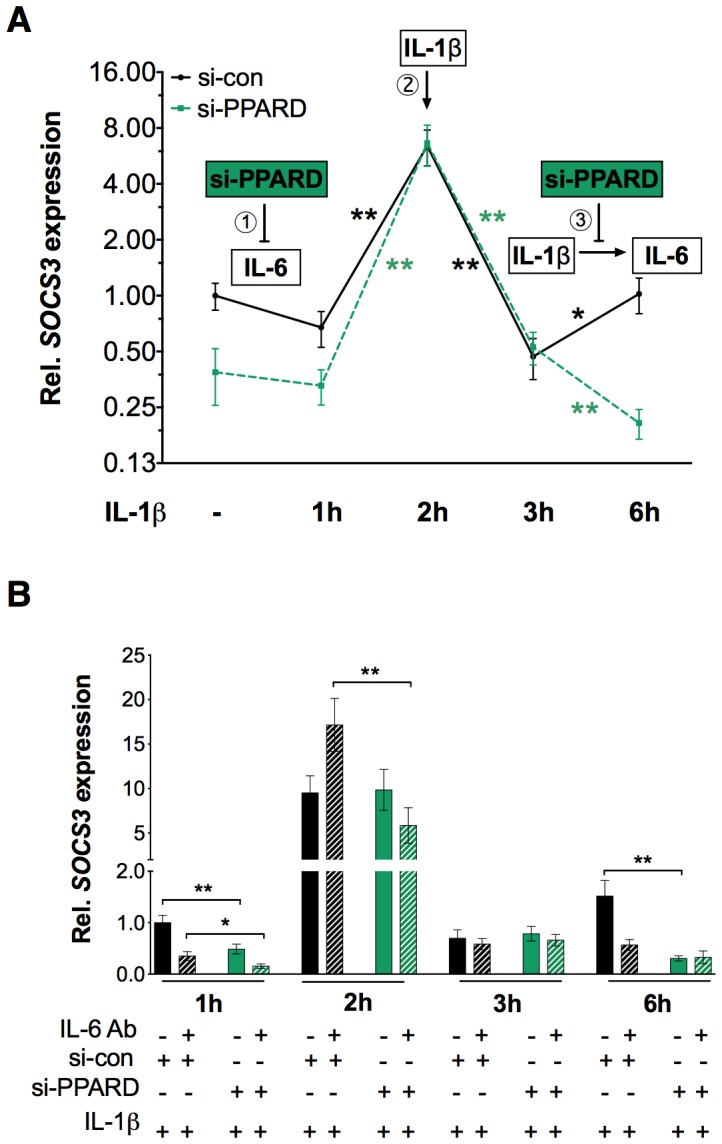
Modulation of IL-1β-mediated IL-6/SOCS3 signaling by PPARβ/δ.(A) Time course of SOCS3 mRNA expression in IL-1β (10 ng/ml) stimulated HeLa cells in the presence of si-con and si-PPARD. Three regulatory events are recognizable and indicated by numbers: (1) IL-1β independent down-regulation of SOCS3 by si-PPARD, presumably resulting from PPARβ/δ-regulated basal IL-6 expression; (2) direct SOCS3 induction by IL-1β; and (3) upregulation of SOCS3 as a consequence of IL-1β induced IL-6 secretion, which is inhibited by siPPARD. **, *significant difference between time points (p<0.01, p<0.05 by t-test). (B) The same experimental setup as in panel A, except that neutralizing antibodies against IL-6 or control IgG was included in the cell culture medium, starting 15 h before IL-1β stimulation. **, *significant difference between si-con and si-PPARD-treated cells (p<0.01, p<0.05 by t-test).